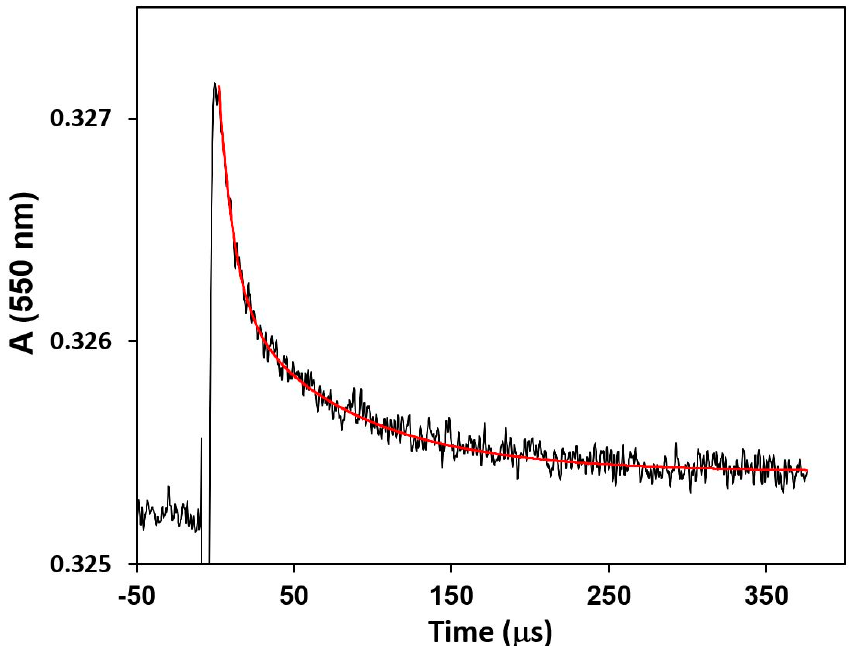
Figure 4. Photoinduced electron transfer from human Ru-39-Cc to bovine CcO showing the laser induced reduction of Cc heme c at 550 nm followed by electron transfer to CcO Cu A . The solution contained 7.6 µ M Ru-39-Cc and 12 µ M CcO in 5 mM TrisCl, pH 8.0, 0.1% dodecyl maltoside, 10 mM aniline, and 1 mM 3CP. The solid line is the best fit to the transient using numerical integration of Scheme 2 as described in the text. k 3 = 62,000 s − 1 and k 4 = 30,000 s − 1 .